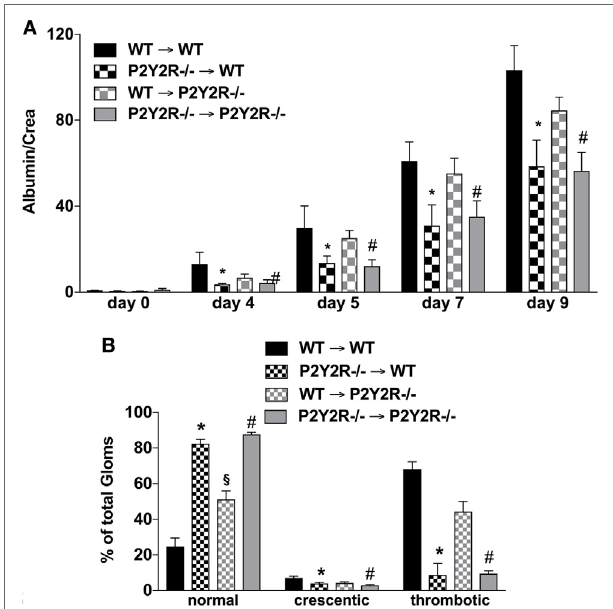
FigUre 6 | P2Y2 − / − deficiency in the haematopetic system is associated with reduced inflammation following nephrotoxic serum (NTS)-induced glomerulonephritis (GN). The different wild-type (WT) and P2Y2R BM-chimera mice received NTS (solved in PBS) intravenous on days 1, 2, and 3 to induce GN. Urine was collected on days 4, 5, and 9 and analyzed for its albumin– creatinine quotient (a) . Animals were killed on day 10. From the killed animals, kidney tissue was prepared and analyzed with microscopy (PAS-staining). Approximately 100 Glomerula in each sample were analyzed following the histological criteria “normal, crescentic, or thrombotic” (B) . Data are shown as mean ± SEM, n = 5 mice in each group. * P <